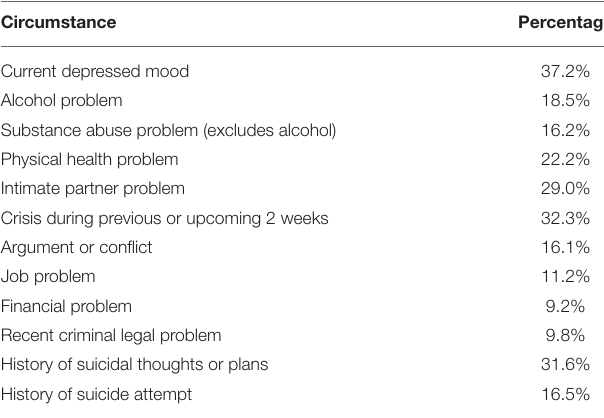
TABLE 3 | Circumstances preceding suicide in men from the US general